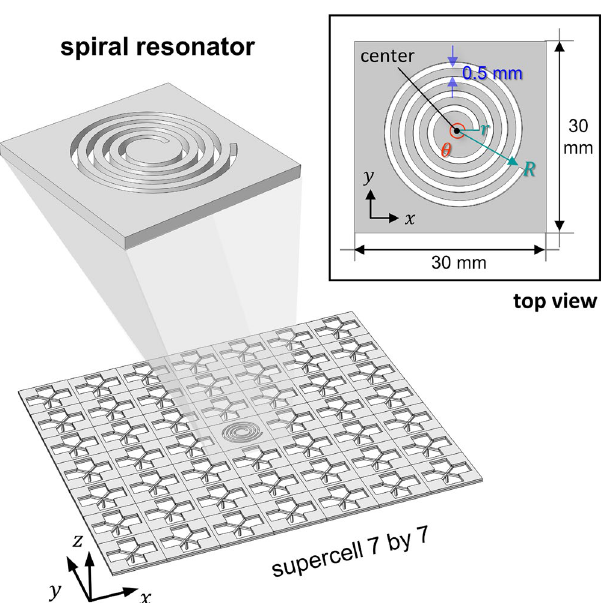
Figure 7. Substitution of the spiral cavity inside the elastic foundation-induced metamaterial. The inset shows the geometric information of the spiral cavity from the top